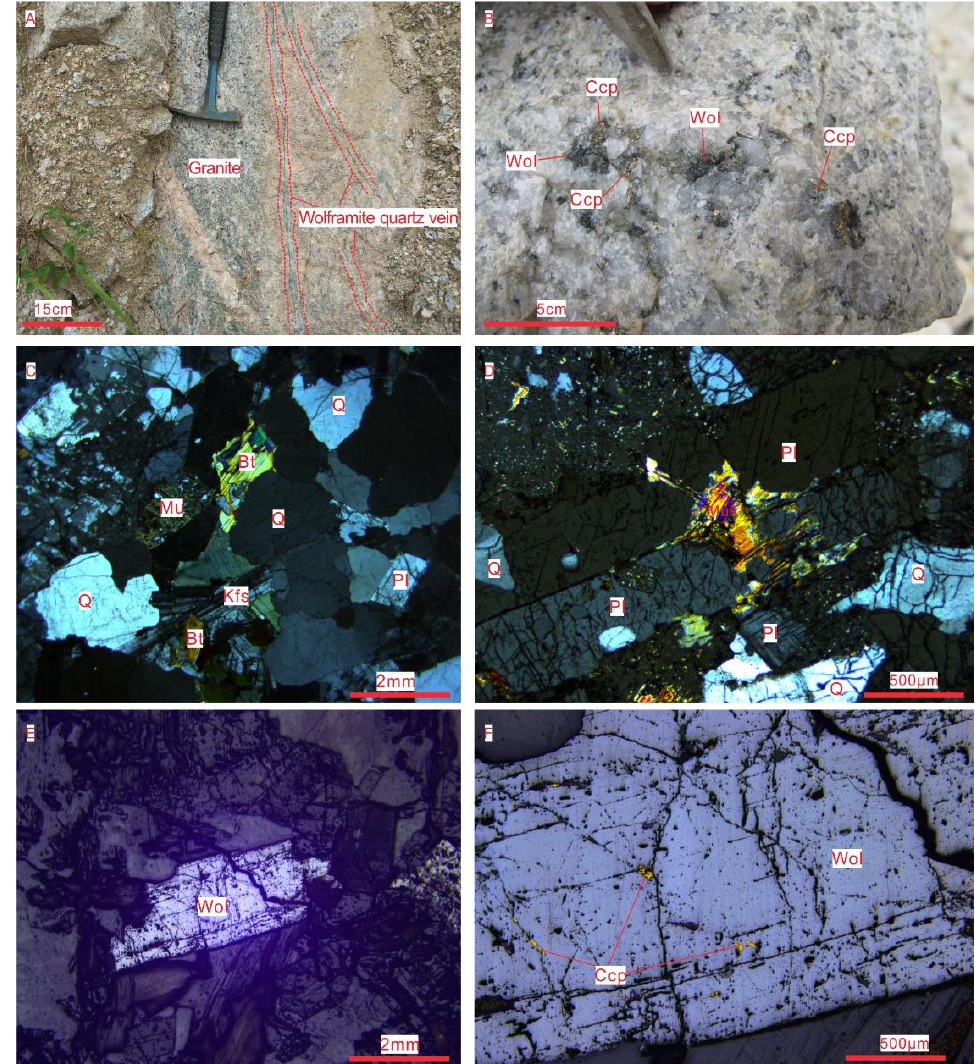
Figure 2. Photographs of Baishi granite. ( A ) Field photo of Baishi granite that contained wolframite quartz veins. ( B ) Hand specimen picture of Baishi granite that contained disseminated wolframite and chalcopyrite. ( C , D ) Cross-polarized light microphotographs of Baishi granite. ( E , F ) Reflected light microphotographs of Baishi granite that contained wolframite and chalcopyrite. Abbreviations: Wol, wolframite; Ccp, chalcopyrite; Q, quartz; Kfs, k-feldspar; Pl, plagioclase; Bt, biotite; Mu, muscovite.